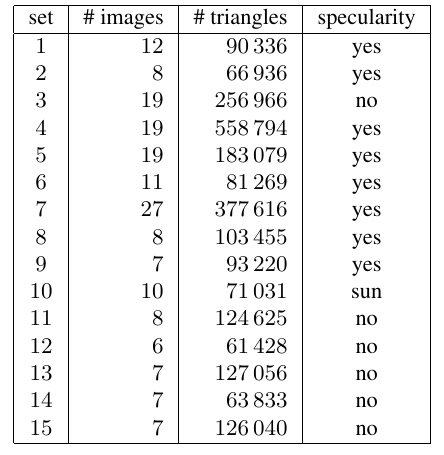
Table 1. Data sets with number of images and reconstructed mesh